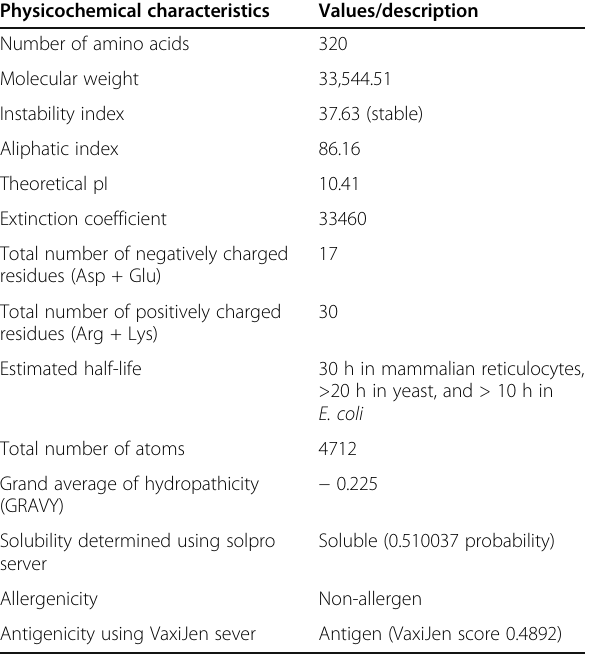
Table 5 Physiochemical Properties of the full-fledged